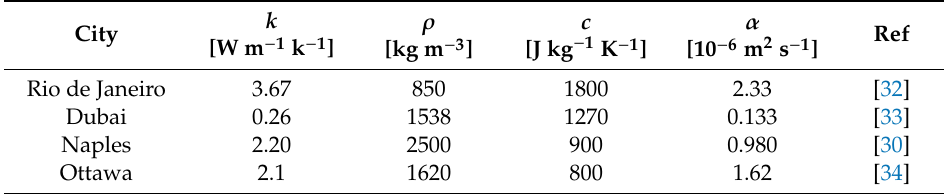
Table 4. Thermal properties of the soil.